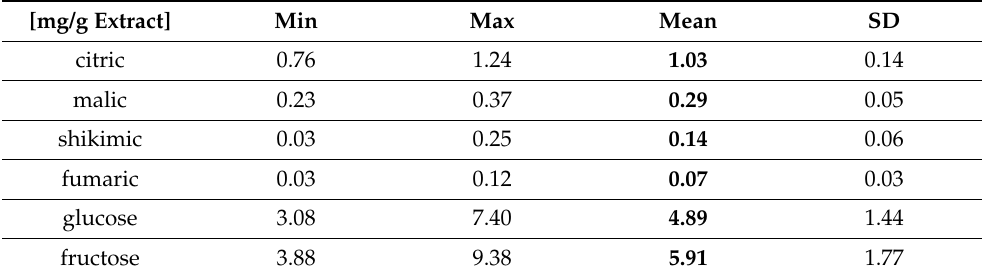
Table 3. The content of organic acids (LMWOAS) and sugars in the elderberry extract. [mg/g Extract] Min Max Mean